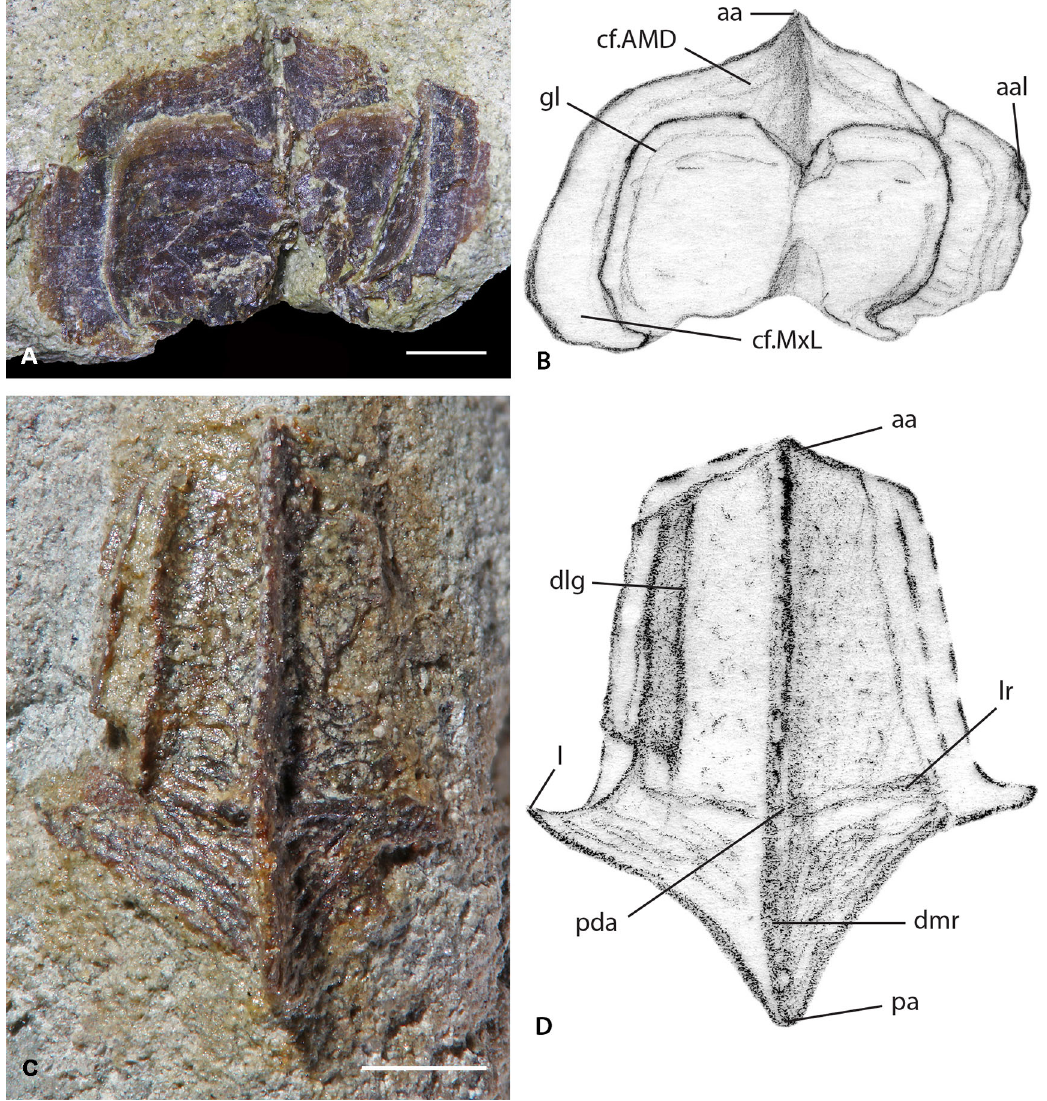
Fig. 6. Microbrachius kedoae from the Gavrilchitsy 45 borehole. Posterior median dorsal plates. A , B , GIT 767-8 in visceral view. C , D , GIT 767-16 in dorsal view. Scale bars = 1 mm. Abbreviations: AMD, anterior median dorsal plate; MxL, mixilateral plate; PMD, posterior median dorsal plate; aa, anterior angle of PMD; aal, anterior lateral angle of PMD; cf.AMD, area overlapping AMD; cf.MxL, area overlapping MxL; dlg, dorsal sensory line groove; dmr, dorsal median ridge; gl, growth line; l, lateral corner of PMD; lr, lateral ridge; pa, posterior corner; pda, posterior dorsal angle of